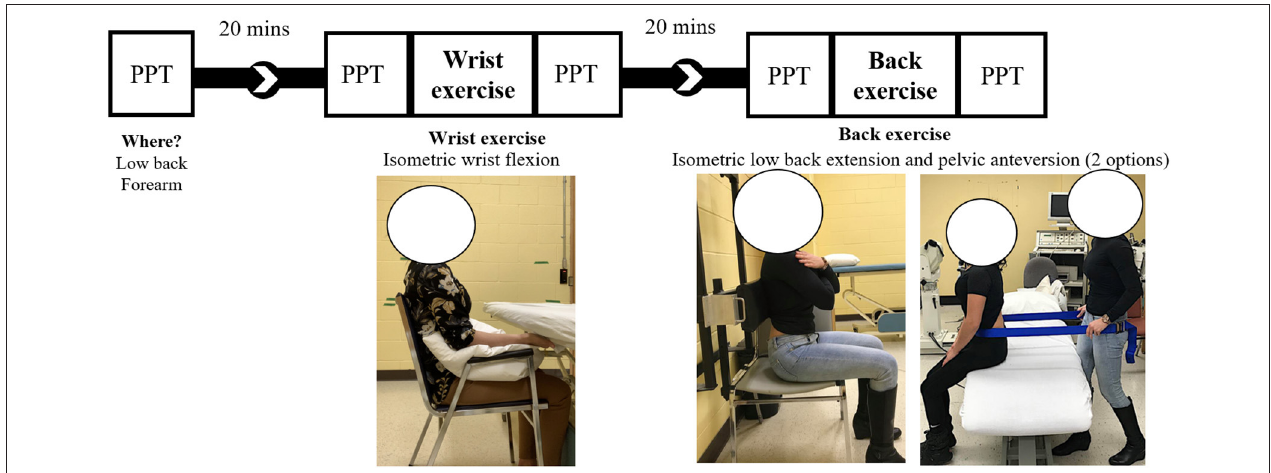
FIGURE 1 | Representation of the study design and exercises. PPT: Pressure pain threshold.